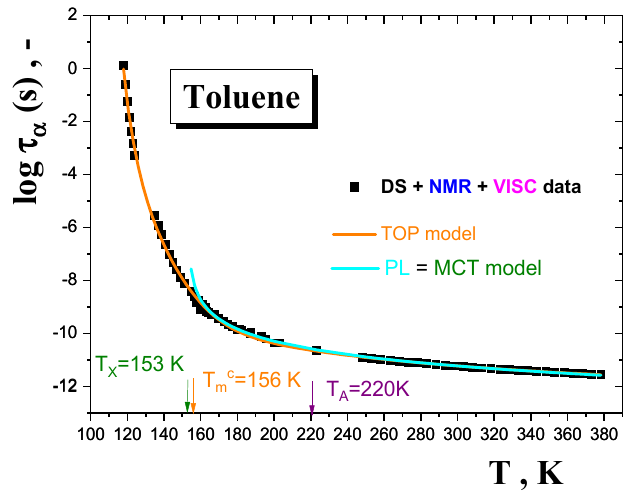
Figure 11. Fits of the structural α relaxation time in amorphous phase of TOL using the PL equation or the idealized MCT model and the TOP model. The PL or MCT parameters are: τ ∞ , α = 5.6·10 − 12 s, T XPL or MCT = 153 K and µ = 1.89. The TOP model parameters are: τ ∞ , α = 1.5·10 − 13 s, E ∞ = 4.6 kJ/mol, T 0TOP = 130 K, T mc = 156 K and T A = 220 K, taken from [55].